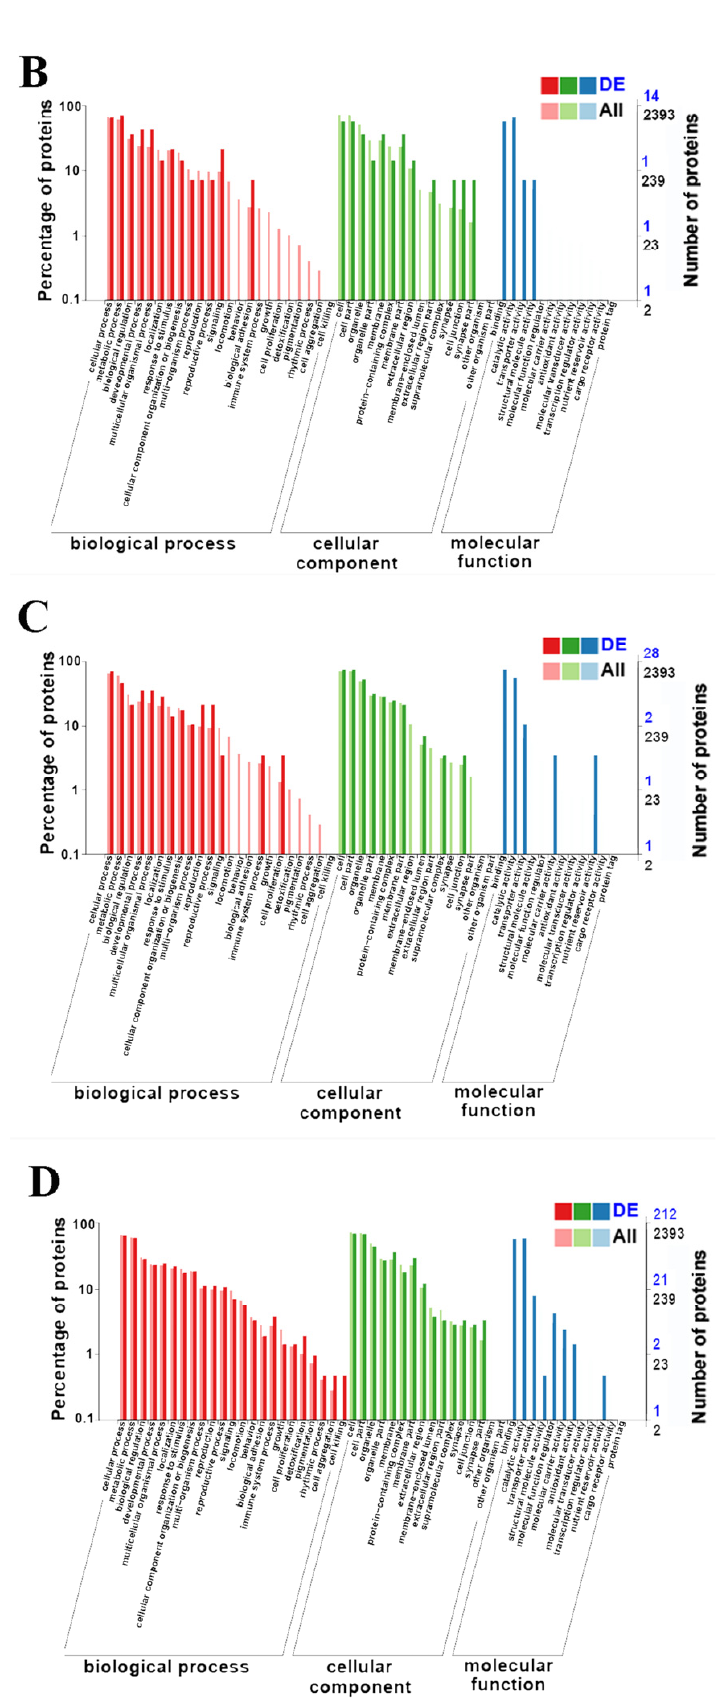
Figure 5. GO enrichment analysis of DEPs in different comparison groups. ( A ) HE-I vs. HE-II, ( B ) HE-II vs. HE-III, ( C ) HE-III vs. HE-IV, ( D ) HE-IV vs.